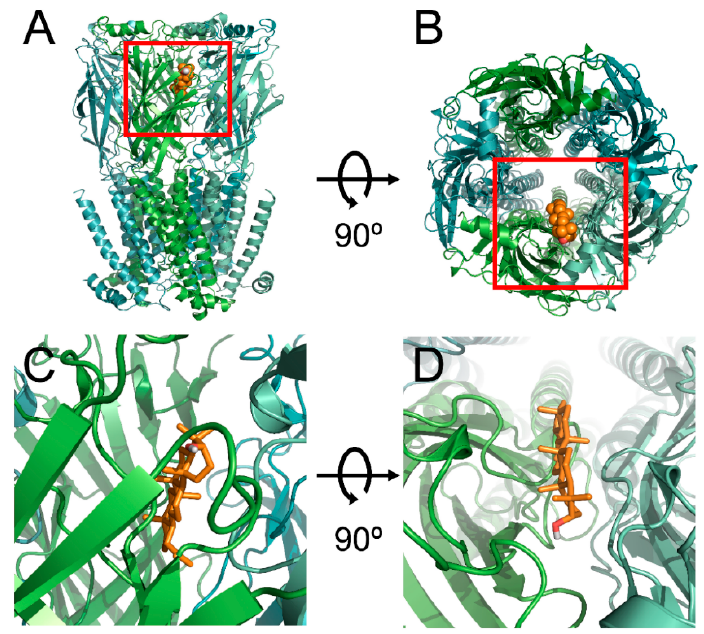
Figure 3. Computational molecular modeling of lupeol docked to α 3 β 4 nicotinic acetylcholine receptor. ( A , C ) Side views of docked lupeol in complex with nACh α 3 β 4 receptor. ( B , D ) Top view of docking